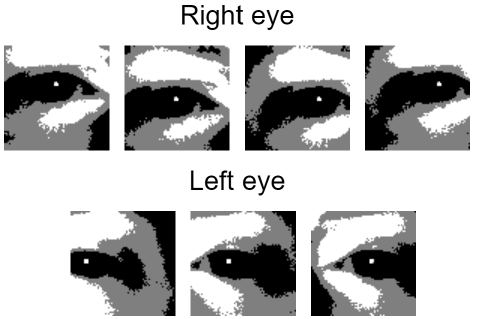
Figure 7. Remaining patches after the pupil reflection check is